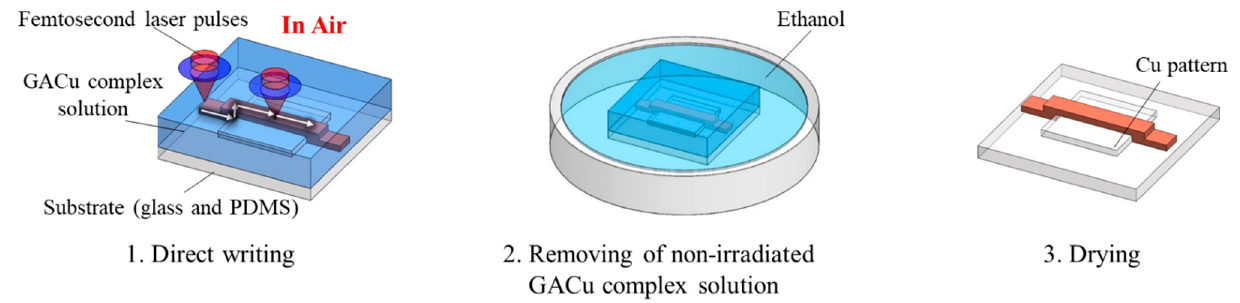
Figure 1. Schematic illustration of the femtosecond laser direct writing on glass or PDMS substrates.